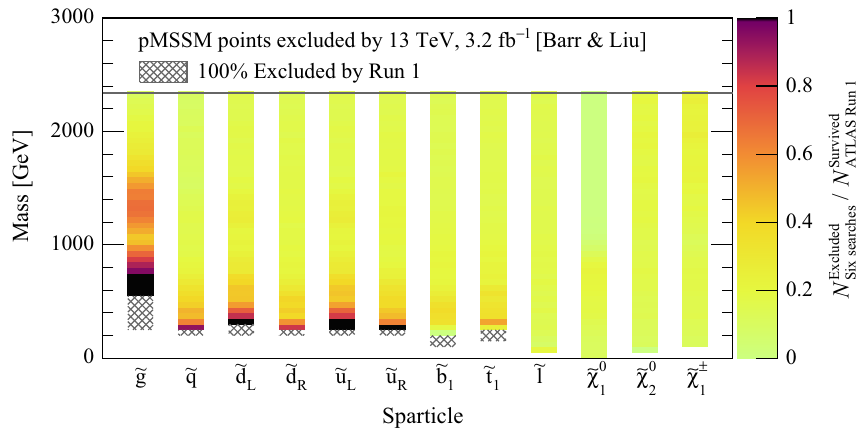
50 GeV size. Here, ˜ q ( ˜ l ) is the lightest squark (slepton) of either the first or second generations. The hatched grey regions indicate all models in the mass bins were excluded by Run 1 ATLAS searches from Ref. [53]. Models with long-lived gluinos, squarks or sleptons are removed from these